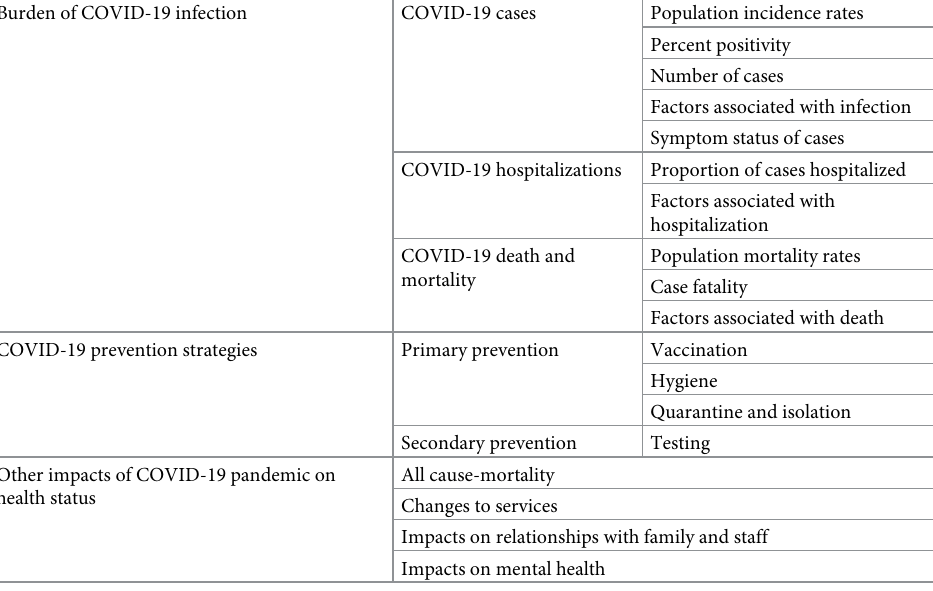
Table 2. Coding framework for systematic review on the health impacts of the COVID-19 pandemic on people who experience imprisonment. Burden of COVID-19